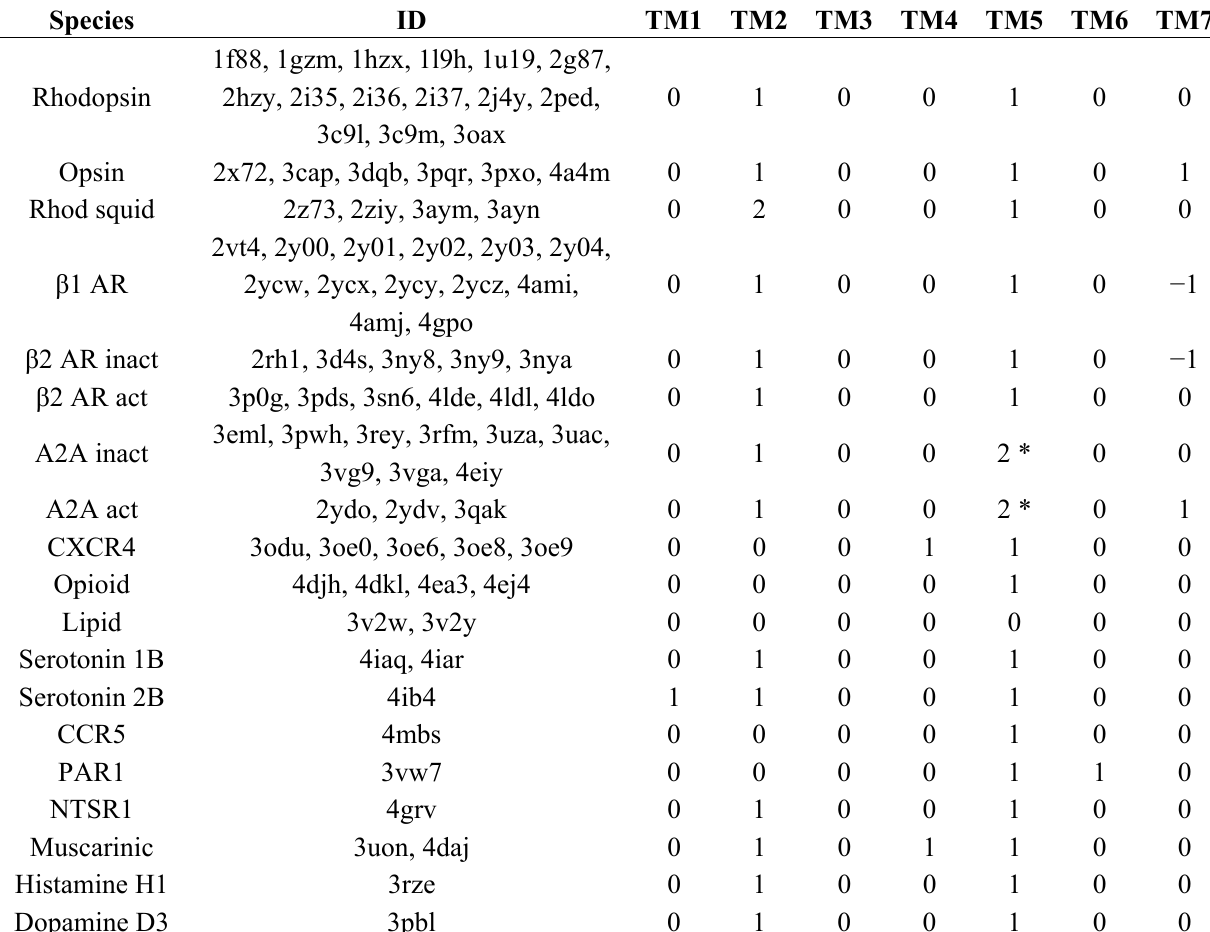
Table 1. Occurrence of α -bulges in the seven helices in the 84 GPCRs. Most α -bulges occur in helix II and helix V (near the ligand-binding pocket). The lipid receptors contain no α -bulges. α -Bulges were determined with DSSP 2.0. Helix VII generally contains a stretch of 3/10 helix near sequence position 720–725 (see Figure 9. The numbers 0, 1, and 2 indicate that we observed zero, one, or two bulges in that helix, respectively. In a few cases one extra turn of 3/10 helix is observed near the cytosolic end of Helix VII; these are indicated with − 1. * Bulge in Helix V of the A2A receptors is twice as long as in other